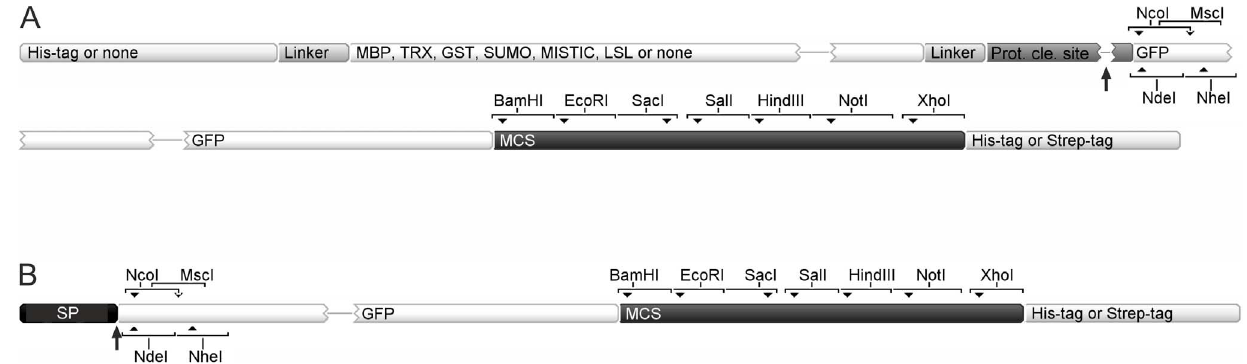
Figure 1. Vector overview of the pCri System. ( A ) Vectors for cytoplasmic protein expression. ( B ) Vectors for periplasmic and extracellular protein expression. An N-terminal His 6 -tag can be fused in all vectors for intracellular expression except of pCri-7. Other tags can also be fused including MBP, TRX, GST, SUMO, MISTIC, and LSL (Table 1–3). In all vectors, a C-terminal His 6 -tag or Strep-tag is attached if a stop codon is omitted within the target gene. Black arrows indicate the proteinase (i.e. TEV, SENP1 or thrombin) and signal peptide (SP) cleavage sites. Restriction sites allowing directional cloning are also shown. For more details regarding each vector, refer to Fig. S1.